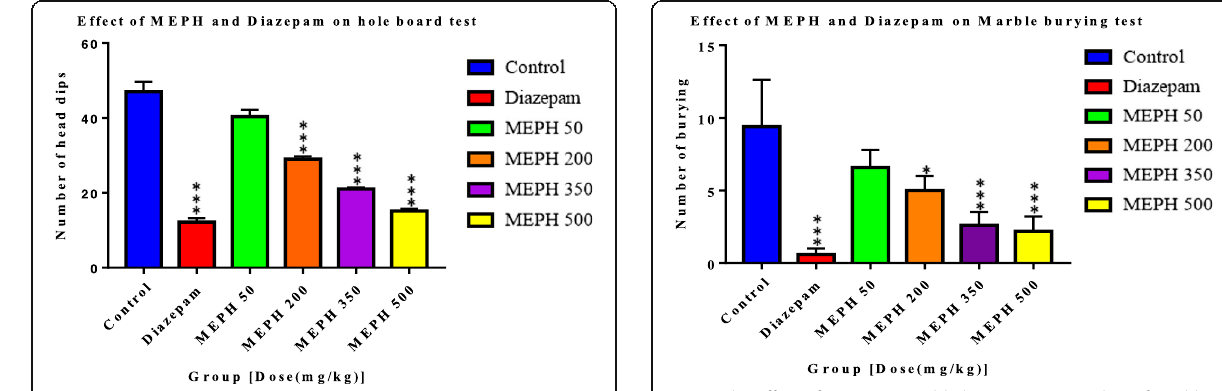
Fig. 7 The effect of MEPH on hole board test (number of head dips) in mice